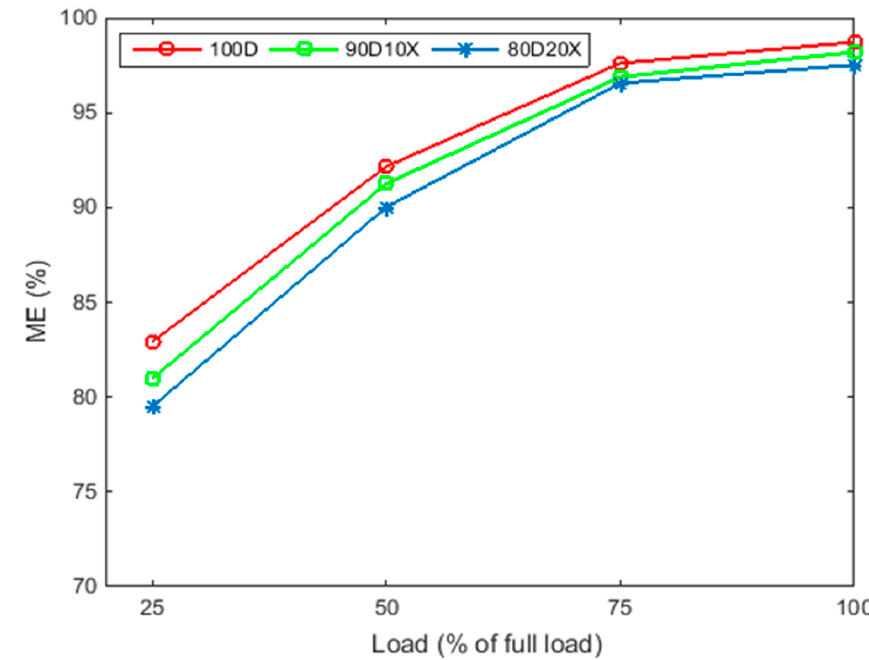
Figure 4. Variation of mechanical efficiency and brake thermal efficiency with engine loads for different fuels.